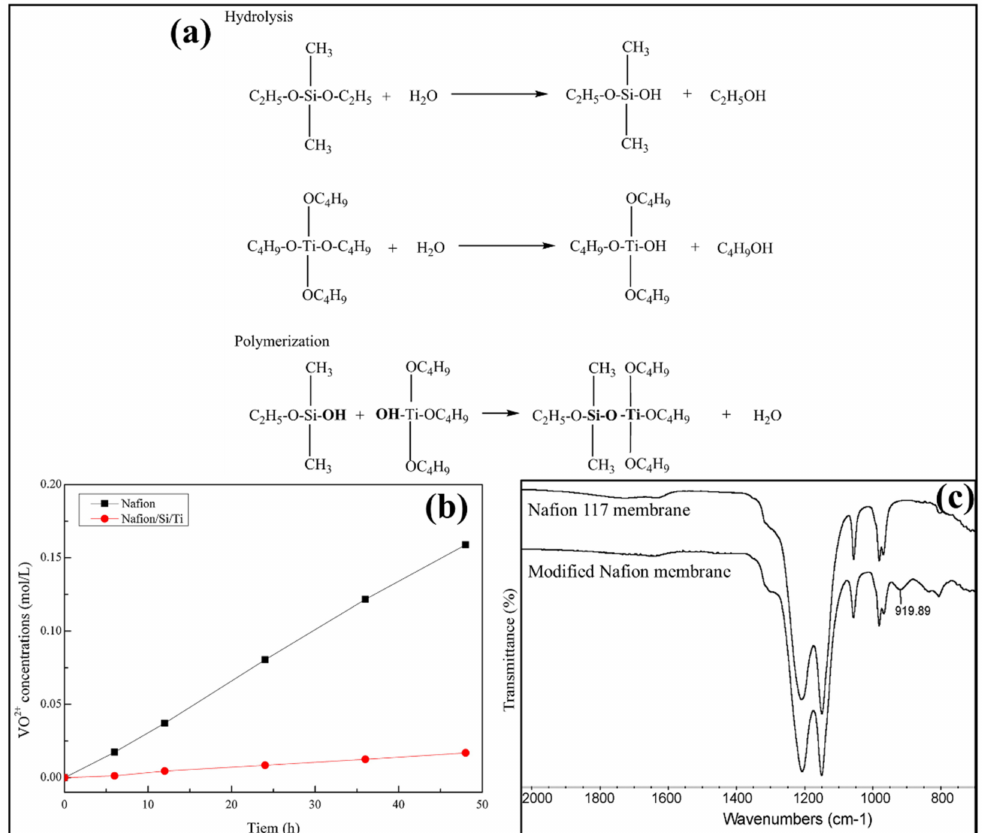
Figure 2. ( a ) Schematic representation of organic silica modified TiO 2 . ( b ) Vanadium ion crossover and ( c ) FTIR analysis of Nafion and modified Nafion membranes. Reprinted with permission from ref. [138]. Copyright © 2009 Elsevier B.V. (License Number: